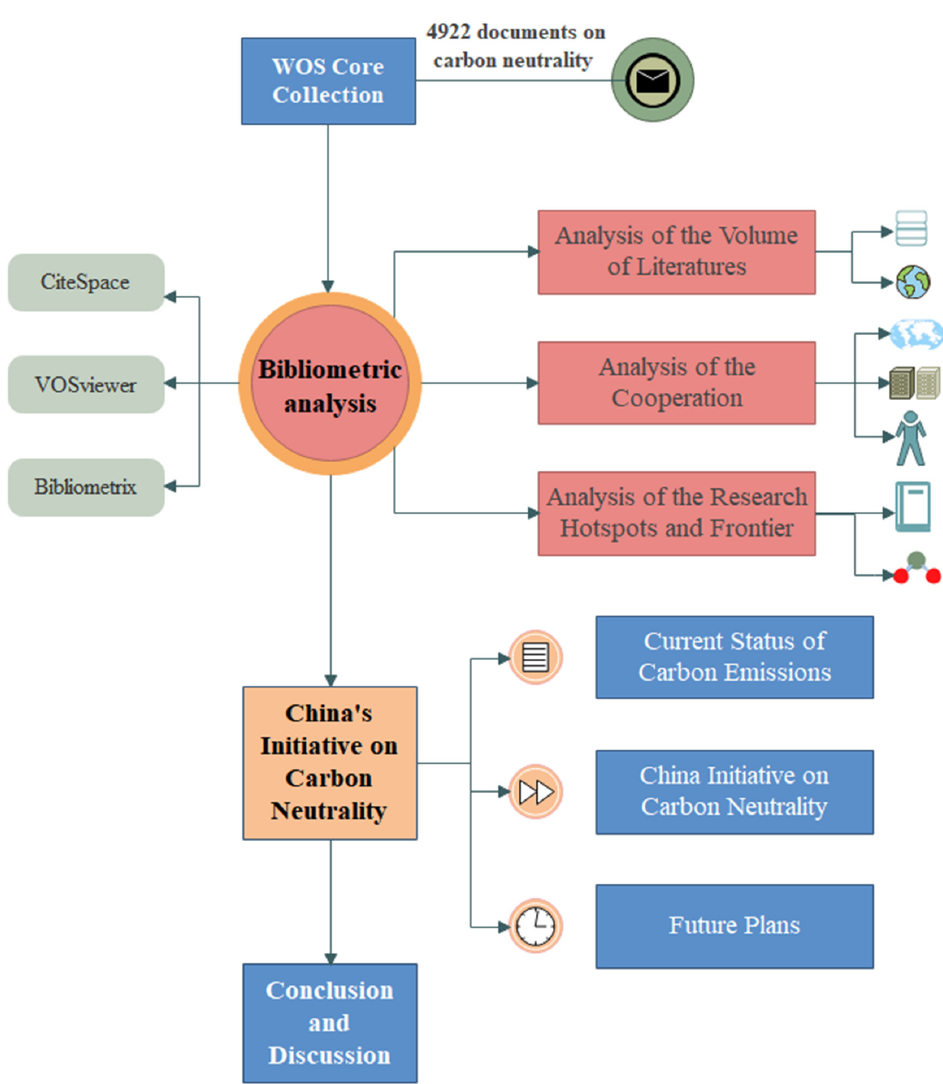
Figure 1. Framework and